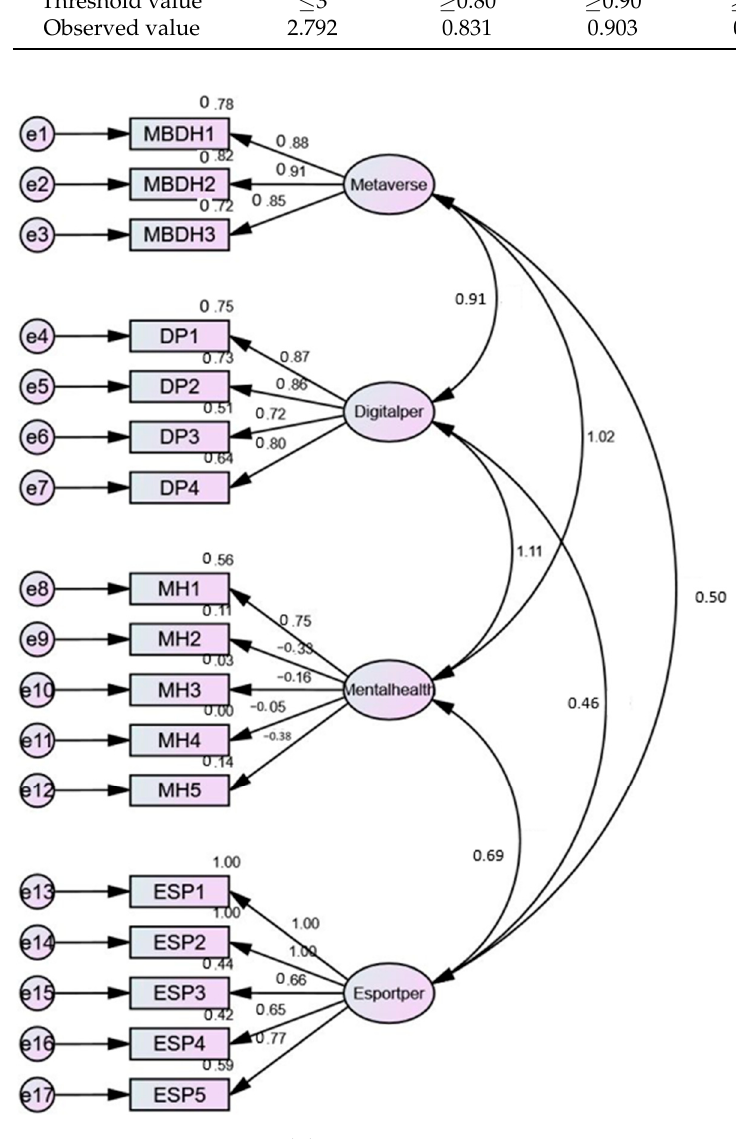
Figure 2. Measurement model.